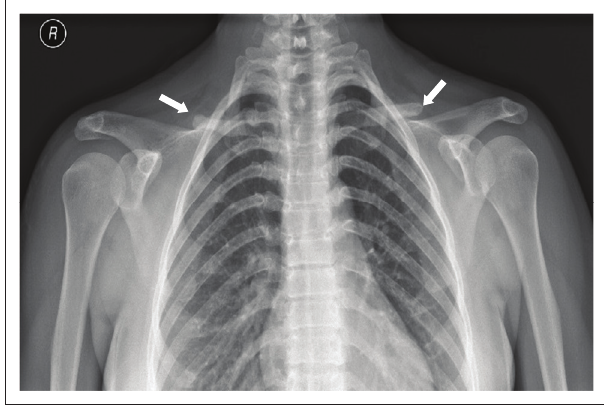
FIGURE 3: Postero-anterior radiograph of the upper chest shows aplasia of lateral two-thirds of both clavicles (white arrows) and a bell-shaped thorax.